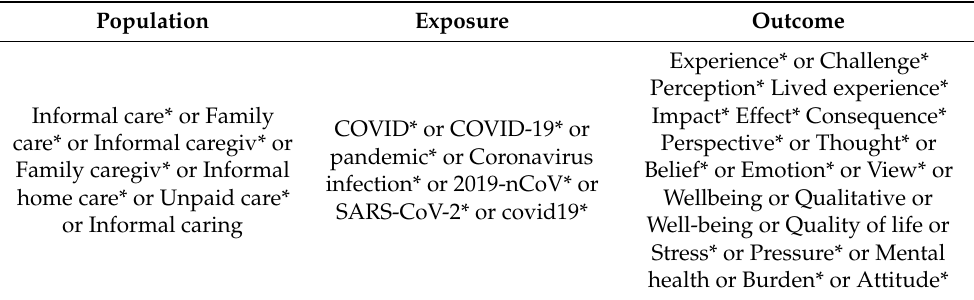
Table 1. Key words used in the database